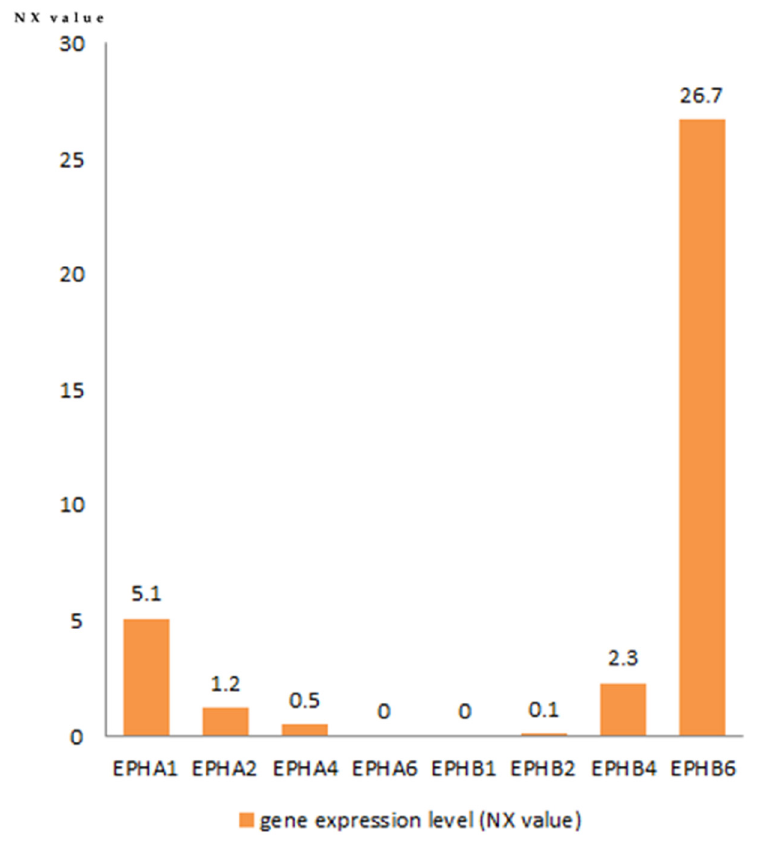
Figure 6. Eph expression in normal thymic tissue. Data retrieved from the Human Protein Atlas database.